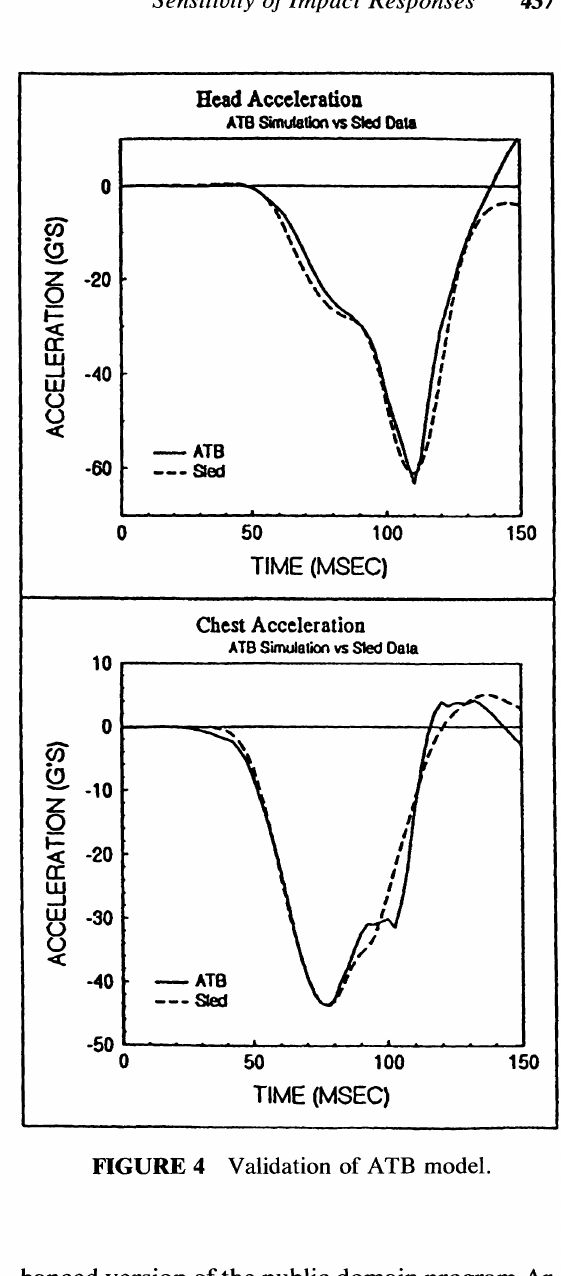
FIGURE 4 Validation of ATB